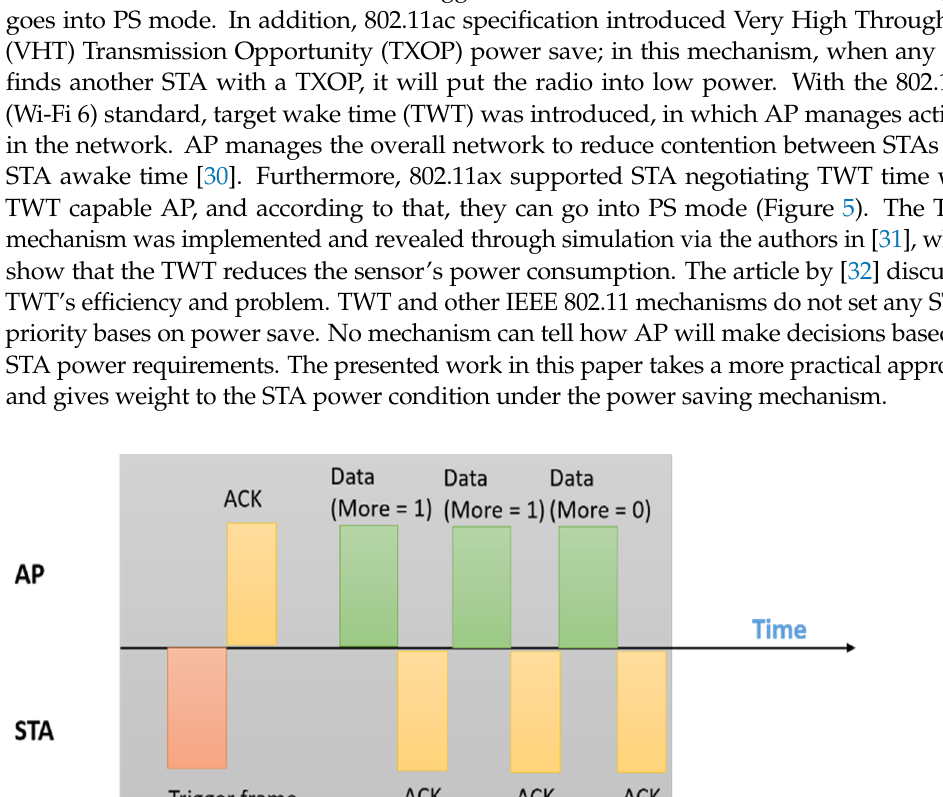
Figure 5. 802.11ax TWT Power Save Mechanism. 4. Design and Architecture of the Proposed Framework The problem can be cast as a framework/protocol limitation aiming to maximize sta- tion battery usage and AP memory under Wi-Fi use cases. Moreover, we intend to pro- pose, without requiring modifications, the standard IEEE 802.11 end devices hardware. We suggest software changes on both sides (STA and AP) of the Wi-Fi device. The first subsection describes access point changes, and the second discusses station side changes. Moreover, these changes are entirely software-driven and do not need any hardware modification. To implement this feature, a user needs to change the Wi-Fi driver and firm- ware of the device and deploy it on the device side. 4.1. AP Framework Description This framework can classify frames based on the frame type and subtype. Different elements play their role according to the requirement. An AP can have many parts, but we discussed and showed the aspects according to our proposed method. This proposal aims to improve battery consumption, especially when the battery dies. It adaptively and dynamically controls AP performance concerning the AP’s buffer and keep-alive time net- work characteristics. Figure 6 shows the proposed framework for the access point. With the proposed method, AP also supports legacy STA devices, which means STA can connect to this AP, even though it does not support dynamic LI. A particular bit is introduced in the beacon to give information about this feature, whether it is supported via AP. Our proposal al- lows the access point to evaluate whether the clients have the right to obtain more buffers. AP framework elements are discussed as follows: